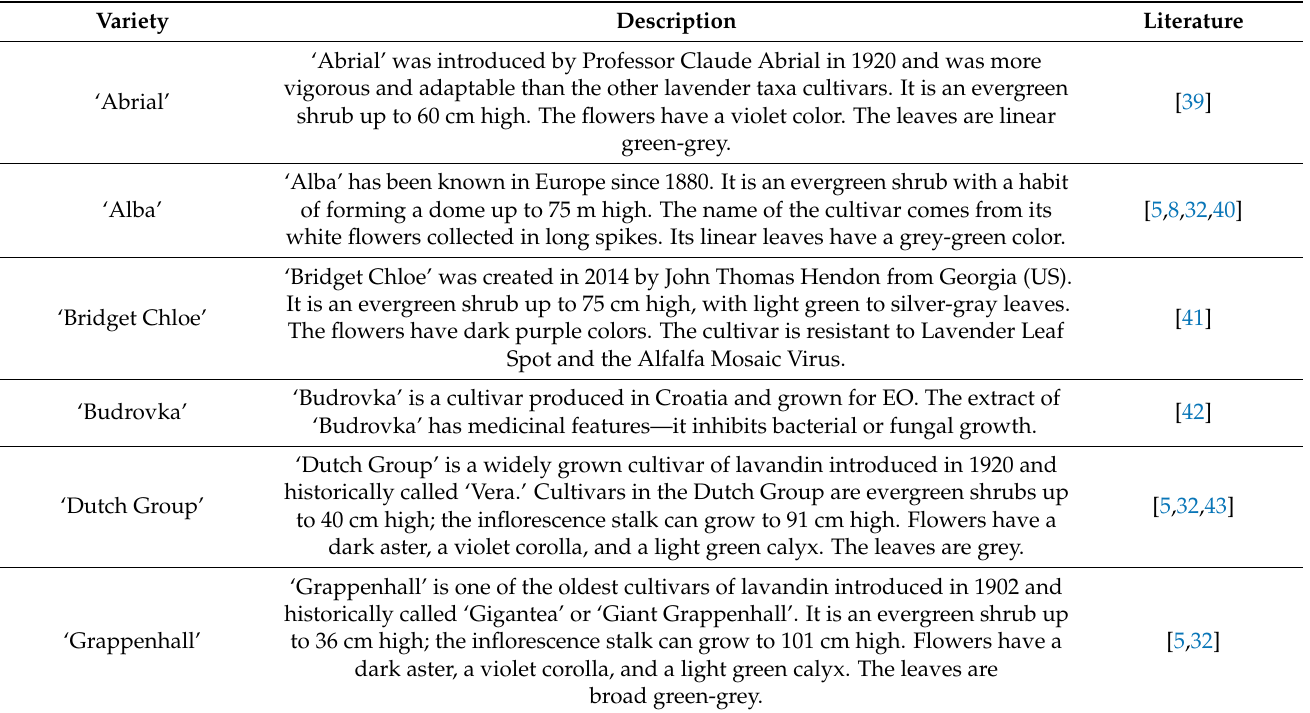
Table 3. Lavandula × intermedia popular cultivar specifications.